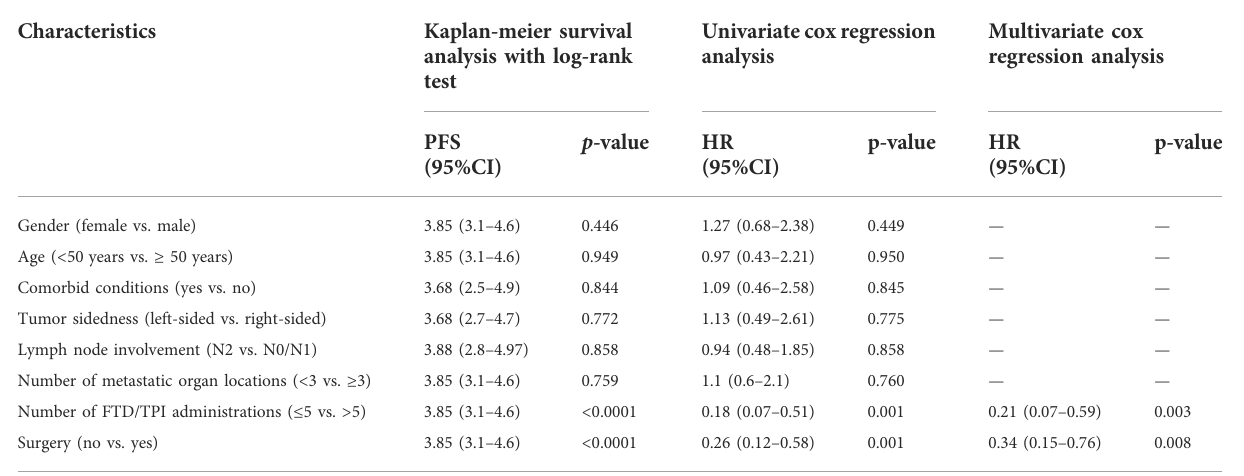
TABLE 3 Association of baseline characteristics with PFS.